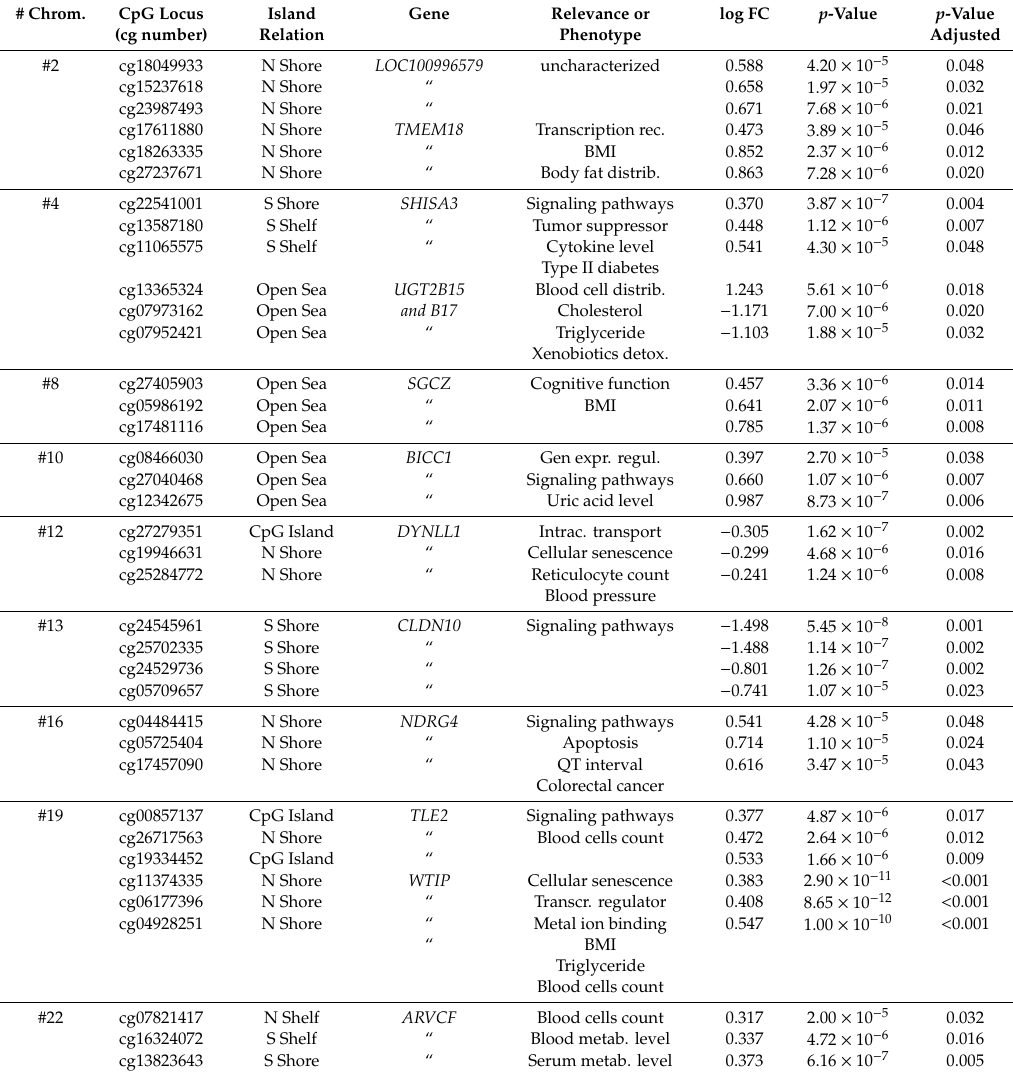
Table 3. Overview of information related to other significant results in the exposed group when compared with the controls with 3 or more di ff erently methylated CpG loci in the same gene. #